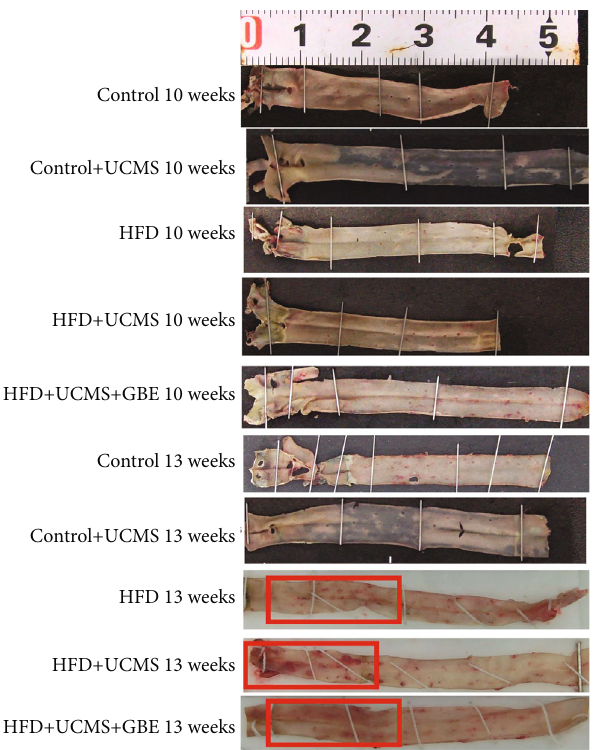
Figure 2: Oil Red staining of vessels. Oil Red staining of the entire aorta in di ff erent groups; the red rectangle presents lipid deposits.